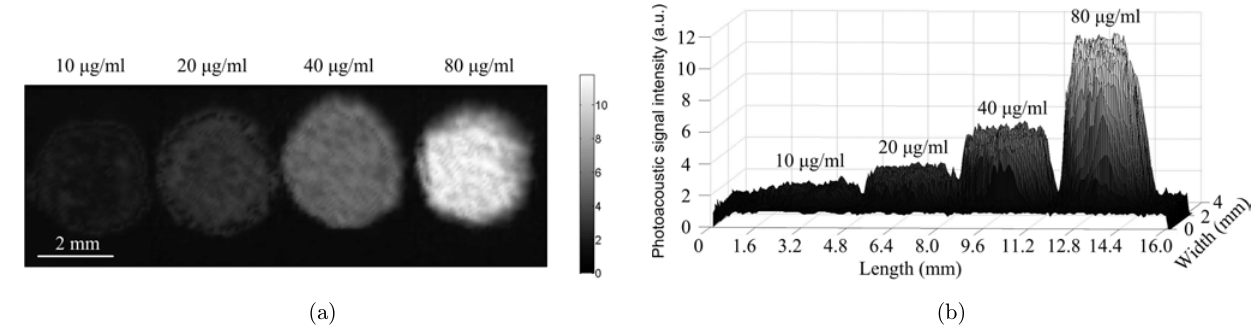
Fig. 4. (a) Photoacoustic imaging of ICG (cid:1) PL (cid:1) PEG nanoparticles at four di®erent concentrations in plastic tubes with a diameter of 3.2mm. (b) Photoacoustic signals of the ICG (cid:1) PL (cid:1) PEG nanoparticles at di®erent concentrations correspond to Fig. 4(a).